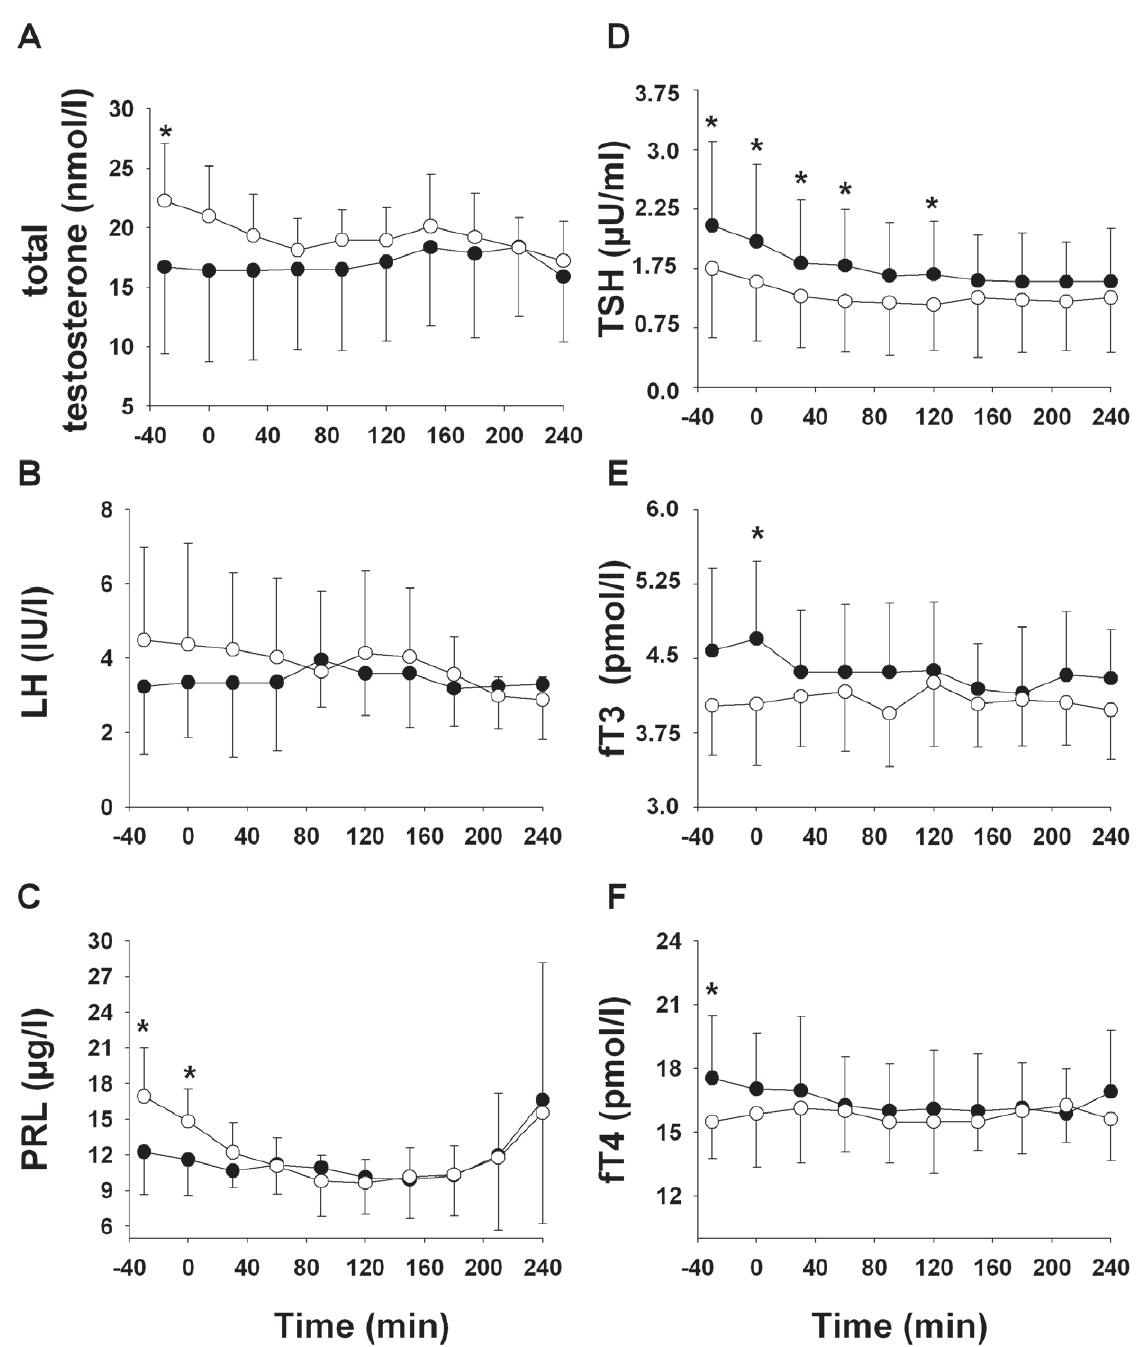
Figure 1. Mean 6 SD concentrations of total testosterone (A; n=8), luteinizing hormone (LH; B; n=9), prolactin (PRL; C; n=9), thyroid stimulating hormone (TSH; D; n=10), free triiodothyronine (fT3; E; n=10), and free thyroxin (fT4; F; n=10) during a 30- minute baseline period and the subsequent 240-minute stepwisehypoglycemic clamp after a night of TSD (black circles) and regular sleep (white circles). P values derive from Student’s t-test for pairwise comparisons. * P ,